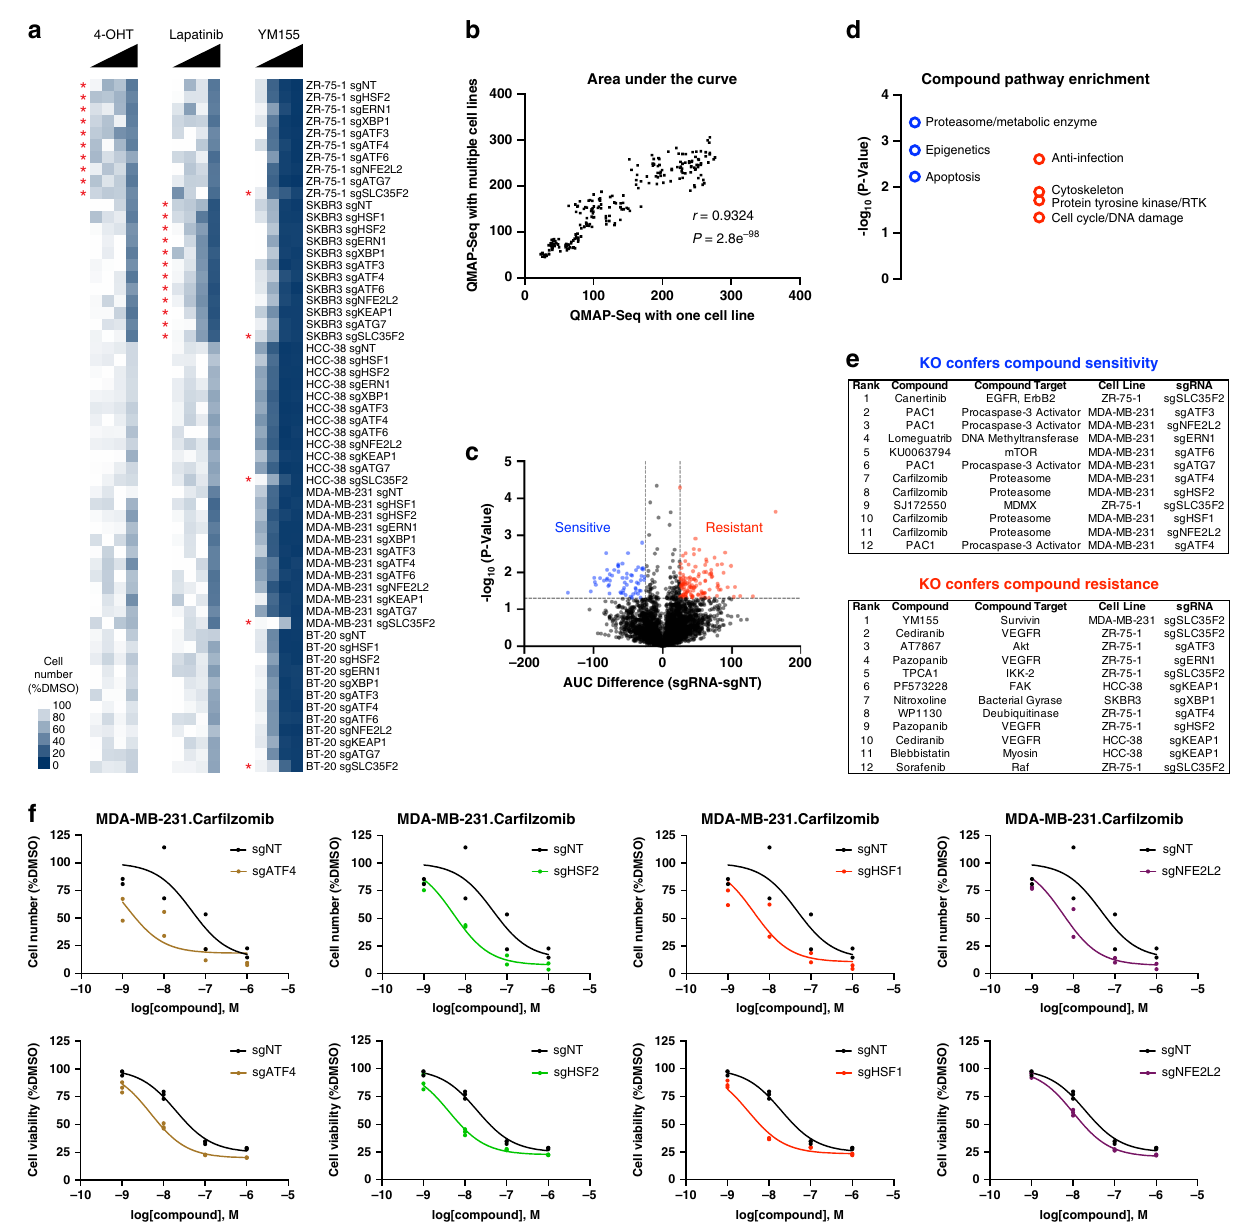
Fig. 3 Identi fi cation and validation of cell line – gene – drug interactions. a Heat maps displaying the relative cell number for each cell line-sgRNA pair 72 h after treatment with 4-Hydroxytamoxifen (4-OHT), Lapatinib, or YM155 as measured using QMAP-Seq. Data are represented as mean of two biologically independent replicates. Asterisks denote positive controls. b Scatterplot of the dose – response curve AUC as determined using QMAP-Seq with one cell line versus QMAP-Seq with multiple cell lines. Common compounds for MDA-MB-231 cells are shown. Statistical signi fi cance of Pearson correlation was determined using a two-tailed test ( n = 220 compound-sgRNA combinations). c Volcano plot depicting cell line – gene – drug interactions. Magnitude was determined by calculating the difference in mean AUC between sgRNA and sgNT for every cell line-compound combination. Statistical signi fi cance was determined using an unpaired, two-tailed t test ( n = 2 biologically independent replicates). Blue dots indicate interactions where the knockout confers greater sensitivity than sgNT. Red dots indicate interactions where the knockout confers greater resistance than sgNT. d Pathways targeted by compounds involved in the top 60 sensitivity interactions (blue circles) or top 124 resistance interactions (red circles) that were signi fi cantly enriched compared to expected pathway representation. Statistical signi fi cance of pathway enrichment was determined using a one-tailed binomial test to compare observed distribution with expected distribution ( n = 180 compounds). e List of the top 12 conditions that confer compound sensitivity or resistance. f Top: Dose – response curves for four of the top chemical – genetic interactions as measured using QMAP-Seq. Each data point represents one of two biologically independent replicates. Bottom: Dose – response curves as measured using Resazurin Cell Viability Kit. Each data point represents one of three biologically independent replicates. For clarity, individual proteostasis factor knockout curves are partioned across four panels; sgNT is same in all